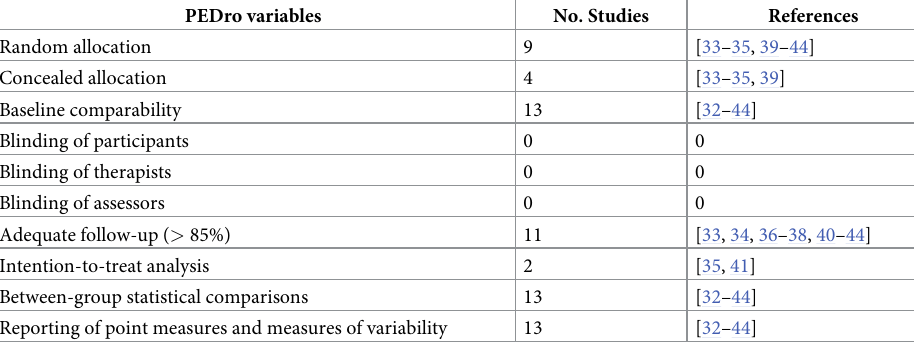
Table 2. Methodological quality measurement of included studies (PEDro